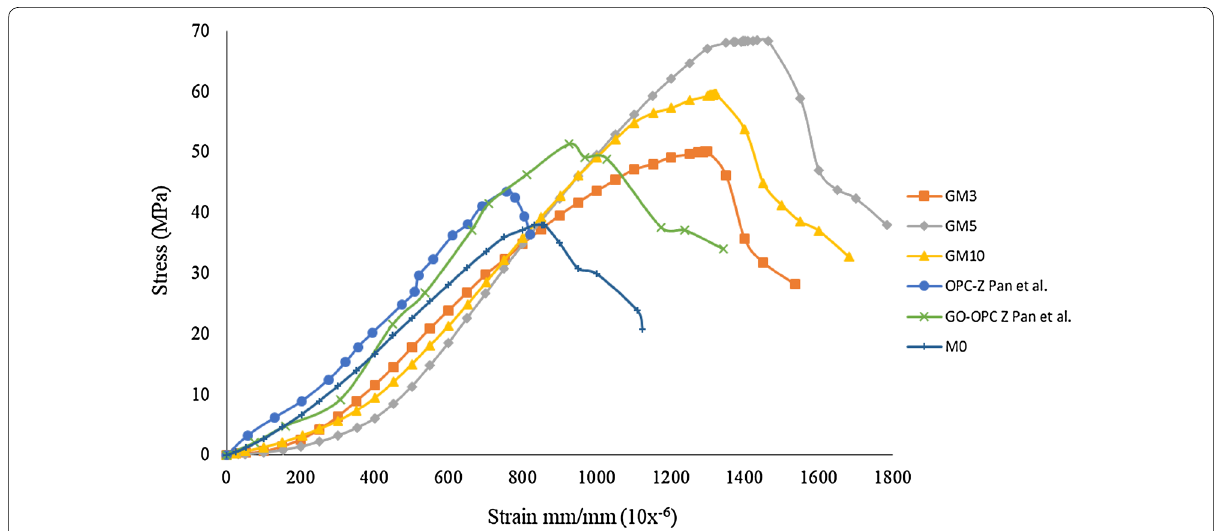
Fig. 5 Stress-strain curve for cement paste (M0), graphene-cement paste (GM3, GM5 and GM10) and GO-OPC by (Pan et al. 2015).